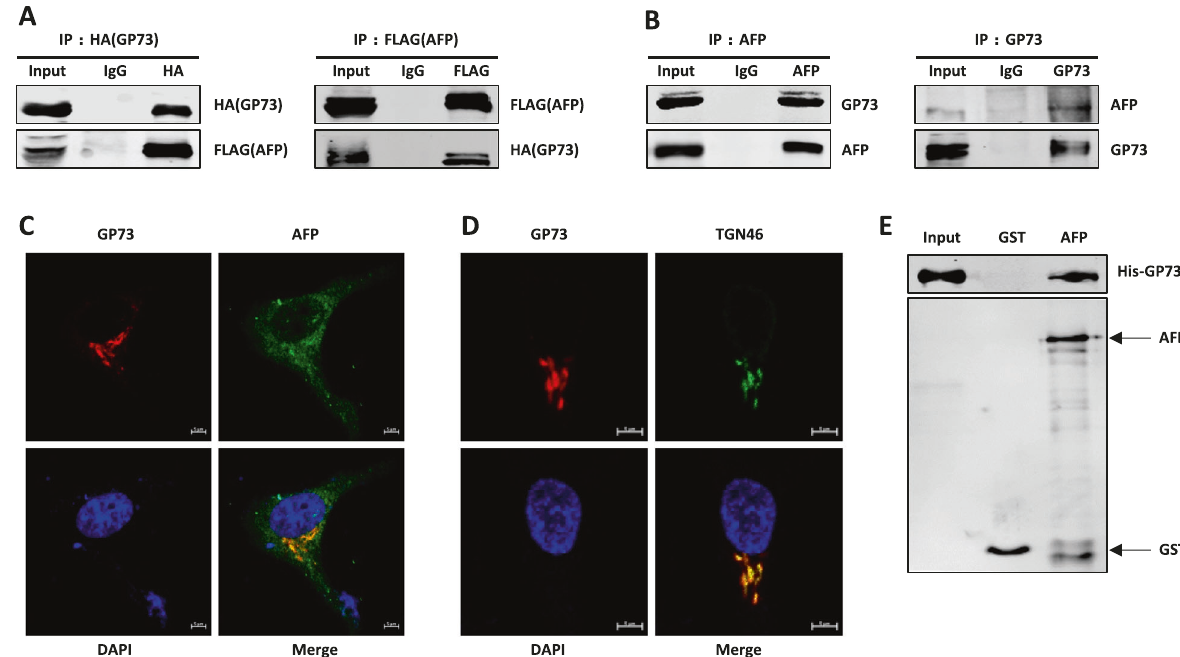
Fig. 2 AFP interacts with GP73 in vivo and in vitro. A , B GP73 interacts with AFP in vivo. A HEK293T cells co-transfected with FLAG-AFP and HA-GP73 were lysed with IP lysis buffer and subjected to immunoprecipitation with anti-HA or anti-FLAG antibodies followed by western blotting with anti-HA or anti-FLAG antibodies. B HepG2 cells were lysed with IP lysis buffer and subjected to immunoprecipitation with anti- AFP or anti-GP73 antibodies followed by western blotting with anti-AFP or anti-GP73 antibodies. C GP73 co-localizes with AFP in cytoplasm. HepG2 cells was stained with GP73 antibody (red) and AFP antibody (green). DAPI (blue), nucleus. Scale bar, 5 µm. D GP73 localizes in the Golgi apparatus. HepG2 cells was stained with GP73 antibody (red) and TGN46 (green). DAPI (blue), nucleus. Scale bar, 5 µm. E GP73 interacts with AFP in vitro. GST pull-down assay was performed by using His-GP73 and GST or GST-AFP proteins in vitro and analyzed by western blotting with anti-His